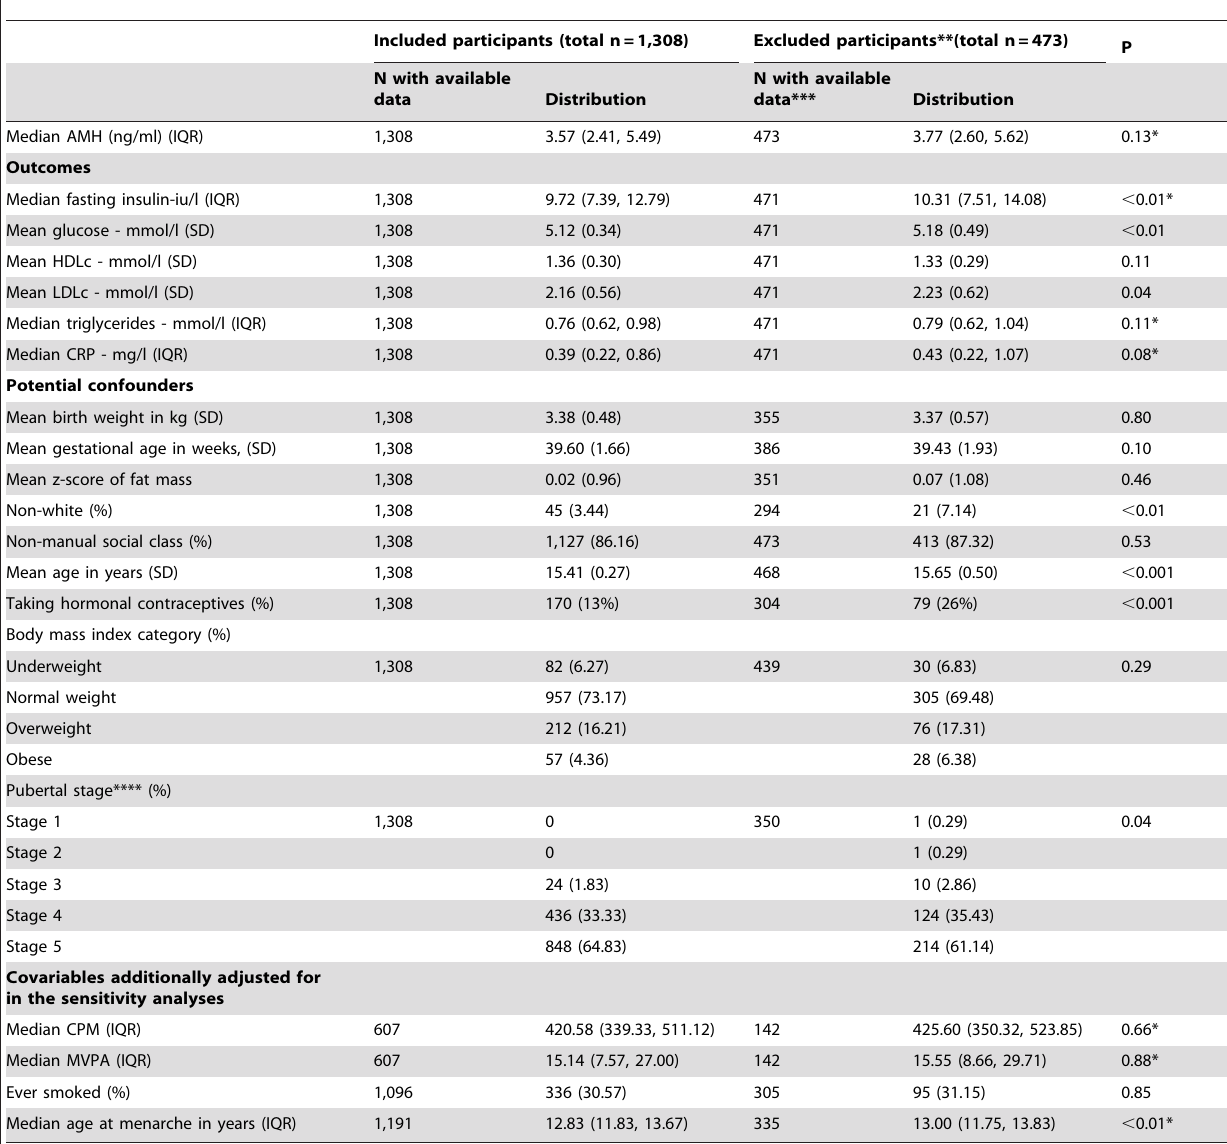
Table 1. Characteristics of participants included in the study (n =1,308), and excluded due to missing data (n=473).